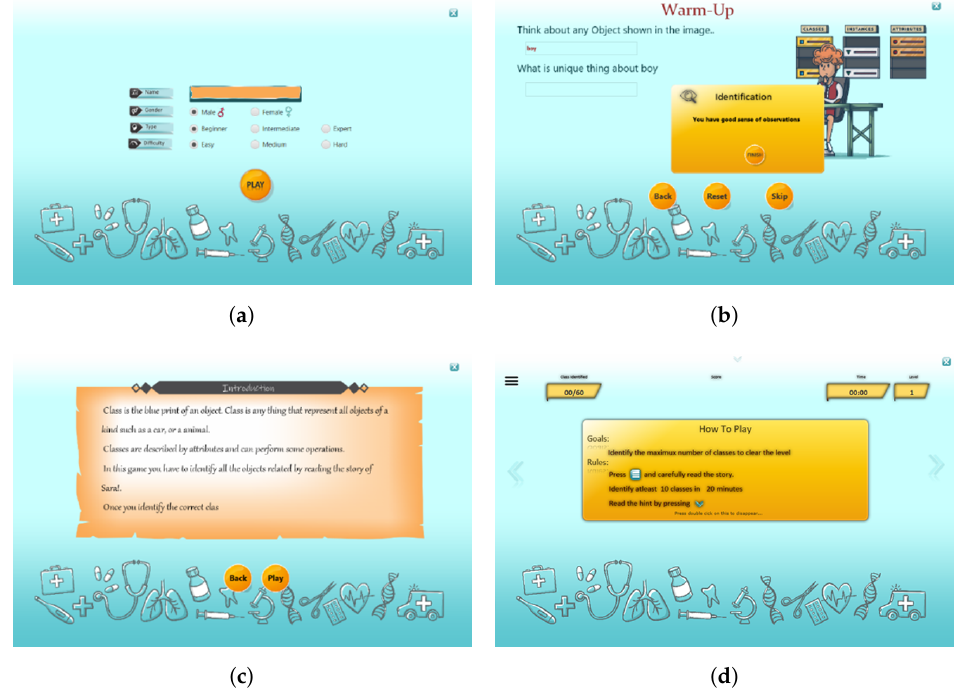
Figure 3. Startup of the screen, the screen includes ( a ) personal and game control information, ( b ) warm-up session ( c ), introduction to the basic concepts needed to be learned, and ( d ) rules and goals for playing the